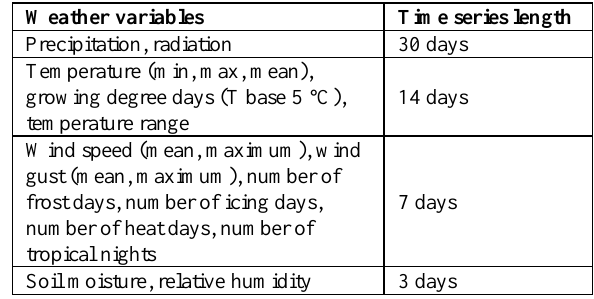
Table 1. Weather variables and associated time series